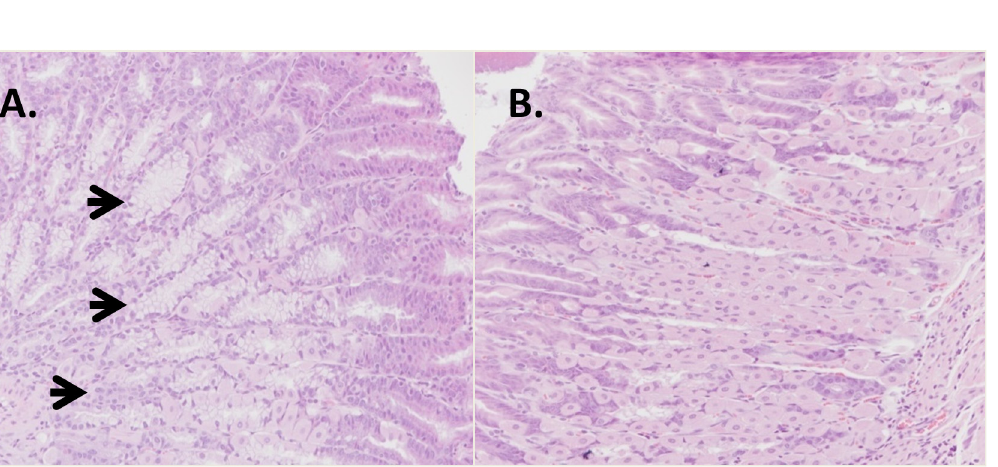
Fig 5. Effect of overexpression of TFF3 on the stomach histology. Stomach tissue from mice that were injected with AAV-TFF3 (A) or the control vector (B) were collected 14 weeks after injection. Four out of six TFF3-treated mice showed clear areas of mucinous metaplasia of the fundic glands, while none of the control group showed this change. All samples were stained with hematoxylin-eosin. Arrows indicate regions of mucinous metaplasia and neutrophil infiltration. All magnifications 100X.